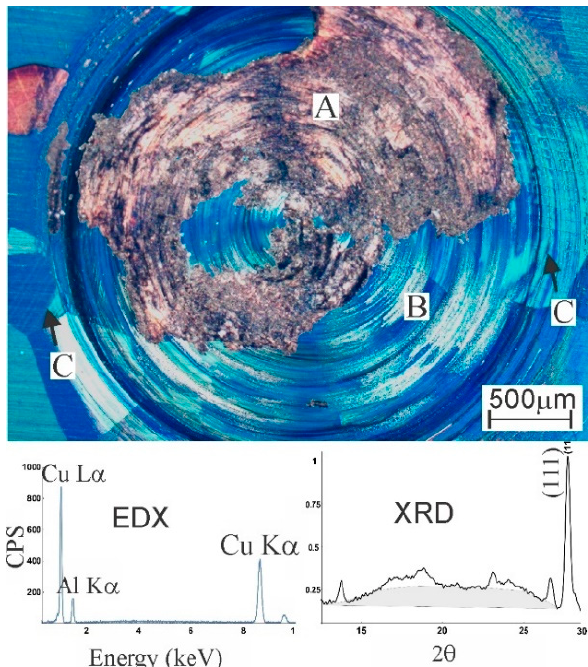
Figure 3. Optical micrograph under crossed polarisers of a HR-sample with an EDX spectrum of zone A and XRD of the entire zone. A corresponds to reincorporated wear debris, B is the heavily deformed surface, C indicates martensite formed around the contact zone.